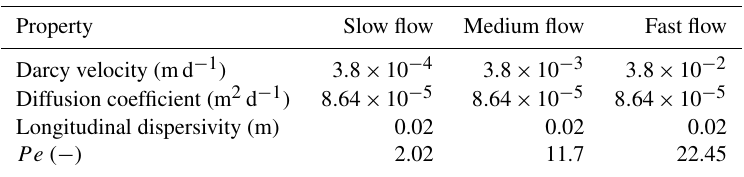
Figure 1. Schematic representation of the simulated biochemical reaction network. Table 1. Flow and transport parameters considered in the simulations and the resulting Péclet number ( Pe ) associated with the different flow regimes. For the latter, the domain size of 0.5m was used as a characteristic length for all flow regimes.